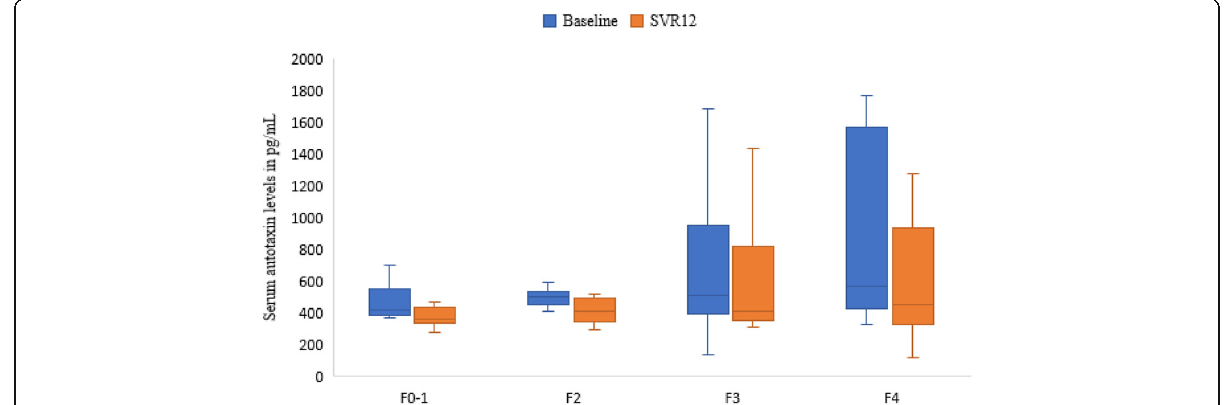
Fig. 2 The sequential changes in serum autotaxin levels according to the grade of fibrosis after achieving SVR12. SVR, sustained virological